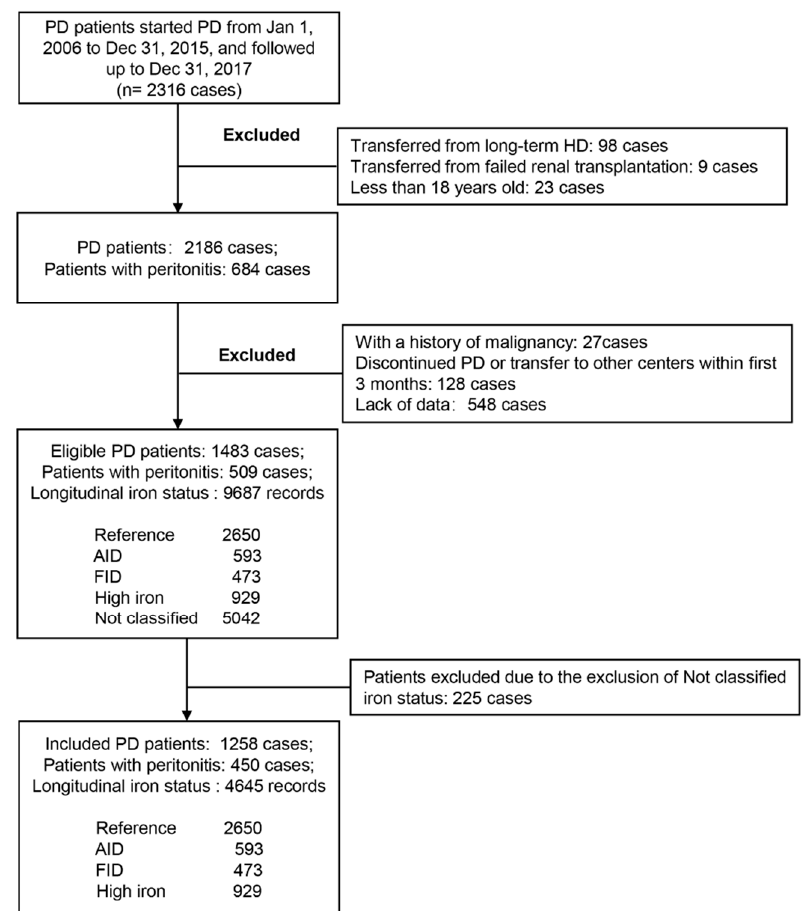
Figure 1. Flowchart of the subject screening process.